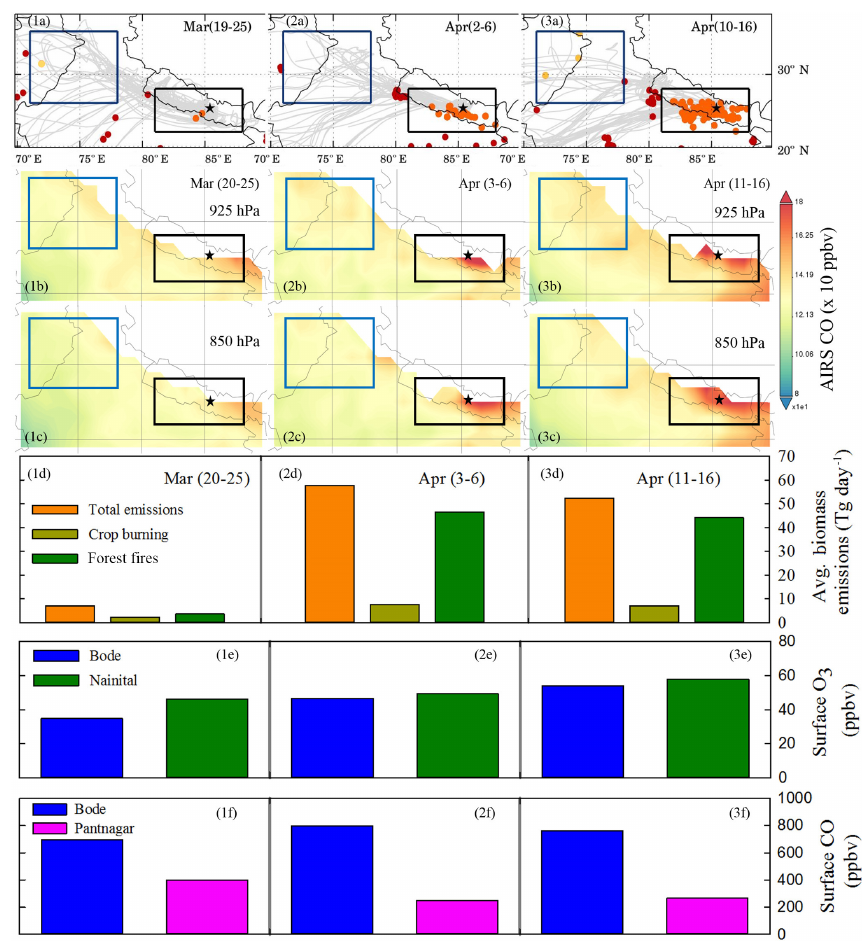
Figure 14. Top (1a–3a) : spatial distribution of MODIS fire counts over the northern Indian subcontinent during three periods (left to right). The black boxes represent two fire hot spots (refer to Fig. S6) over the region with fire counts shown as different colors during the three periods. Center (1b–3c) : spatial distribution of AIRS CO mixing ratio at 925hPa (1b–3b) and 850hPa (1c–3c) during three periods (left to right). Center (1d–3d) : average biomass burning emissions over the Bode region (27–8 ◦ E, 85–86 ◦ E) using the GFED v4.0 inventory during the three periods (left to right). Bottom (1e–3f) : changes in average surface mixing ratios of O 3 (1e–3e) and CO (1f–3f) at different sites during the three periods (left to